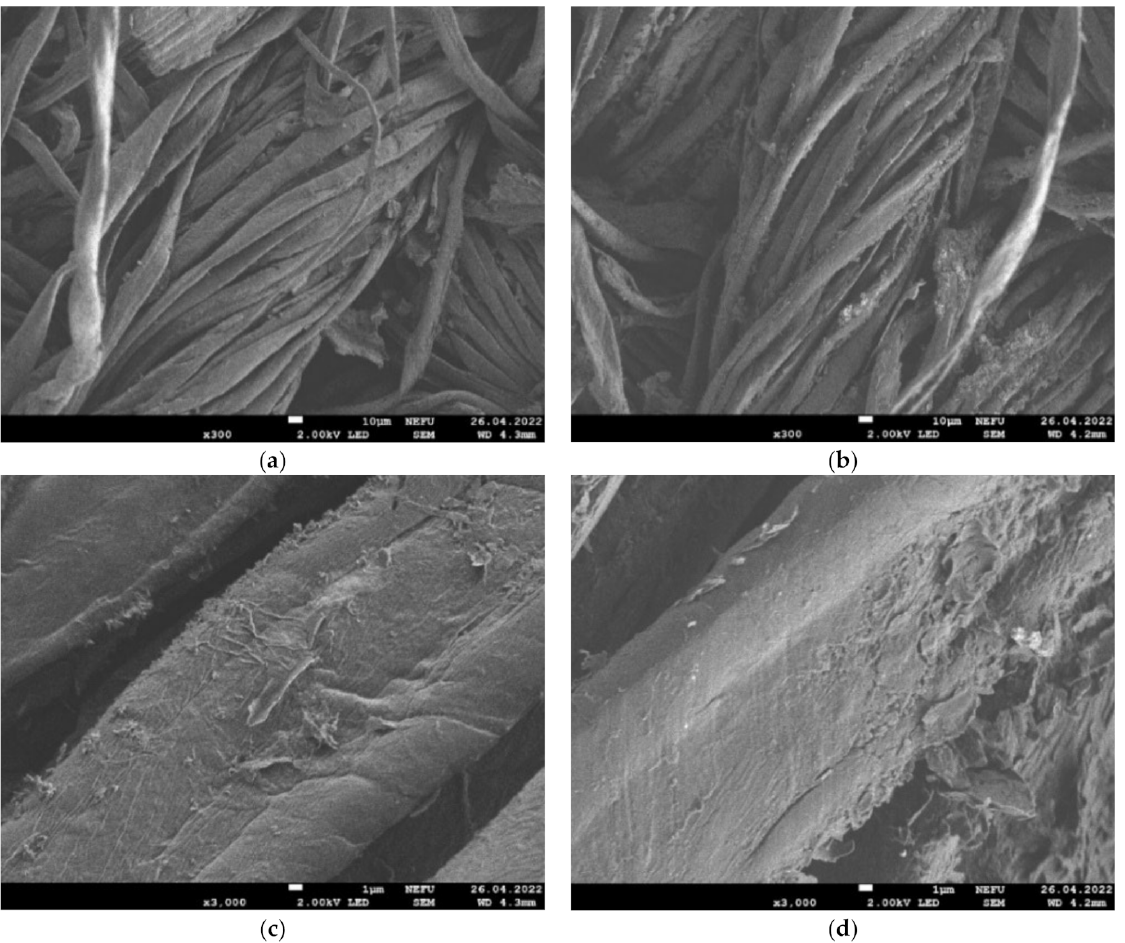
Figure 7. Image of e-textile surface after 10 washing cycles: ( a ) GO at 300 × zoom; ( b ) MOG at 300 × zoom; ( c ) GO at 3000 × zoom; ( d ) MOG at 3000 ×